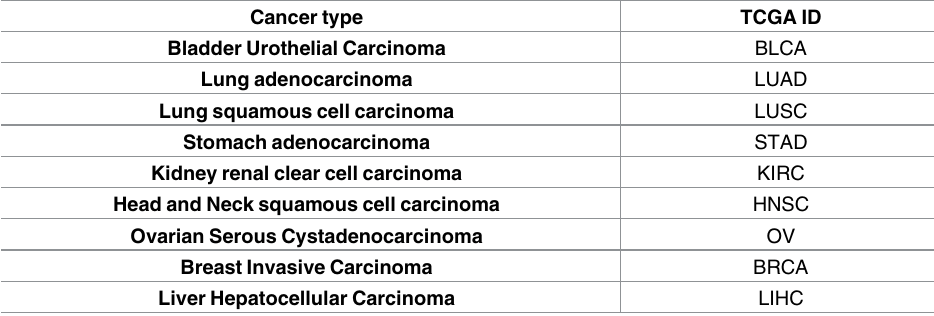
Table 1. Cancer types with rDNA CN estimated in this